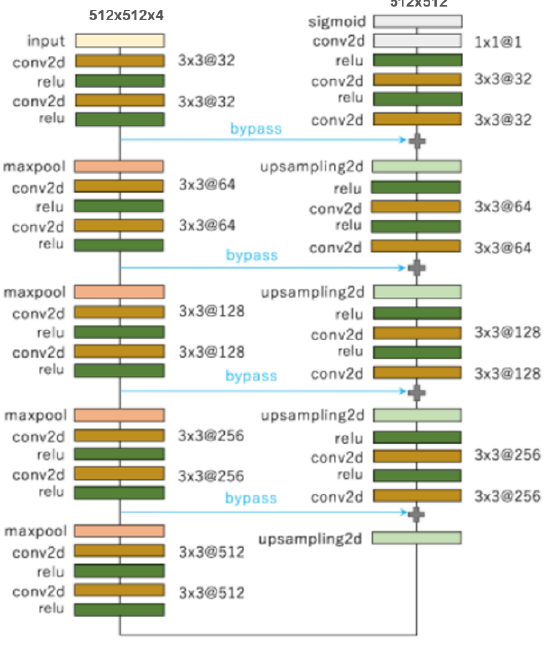
Figure 1. Model Architecture (SpaceNetChallenge, 2017).